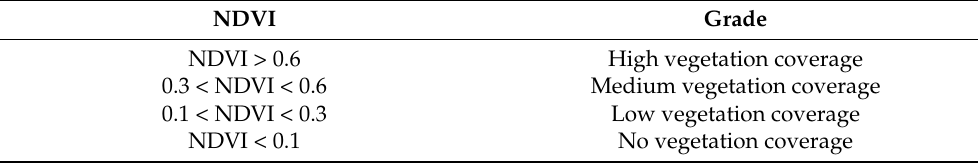
Table 2. Grade of vegetation coverage.